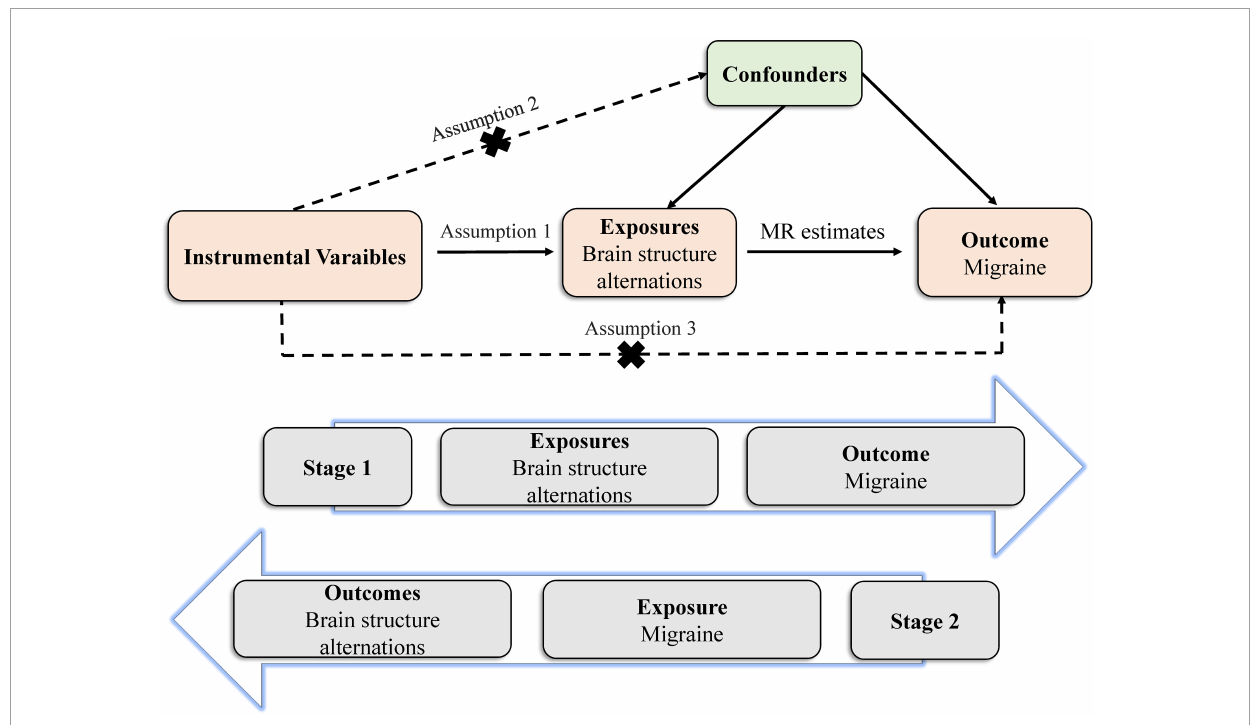
FIGURE1 Principles of the Mendelian randomization study for brain structural alterations and migraine